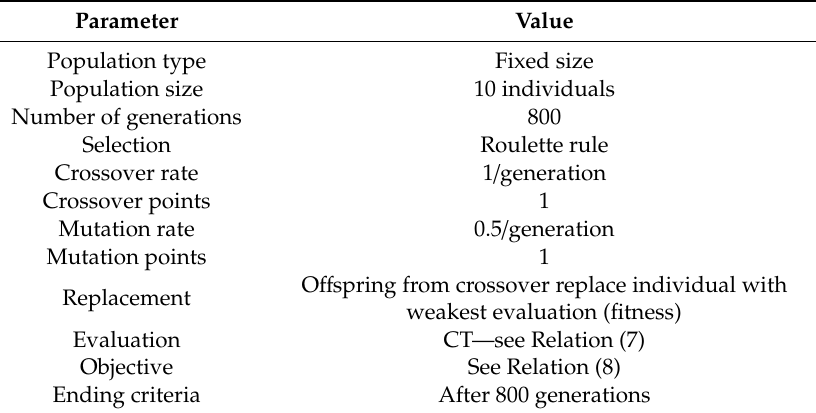
Table 1. Parameters of genetic